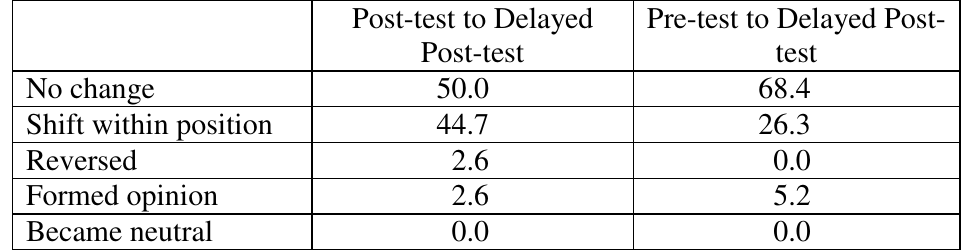
Table 9. Percentage of Participants Exhibiting Changes in Ratings of